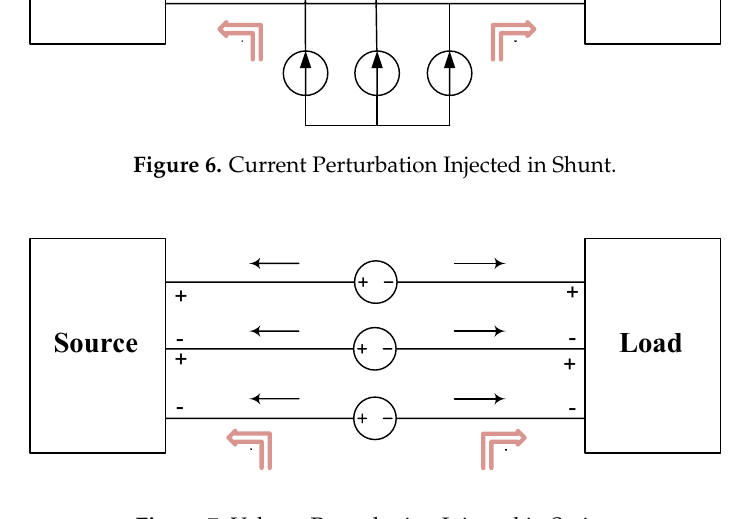
Figure 7. Voltage Perturbation Injected in